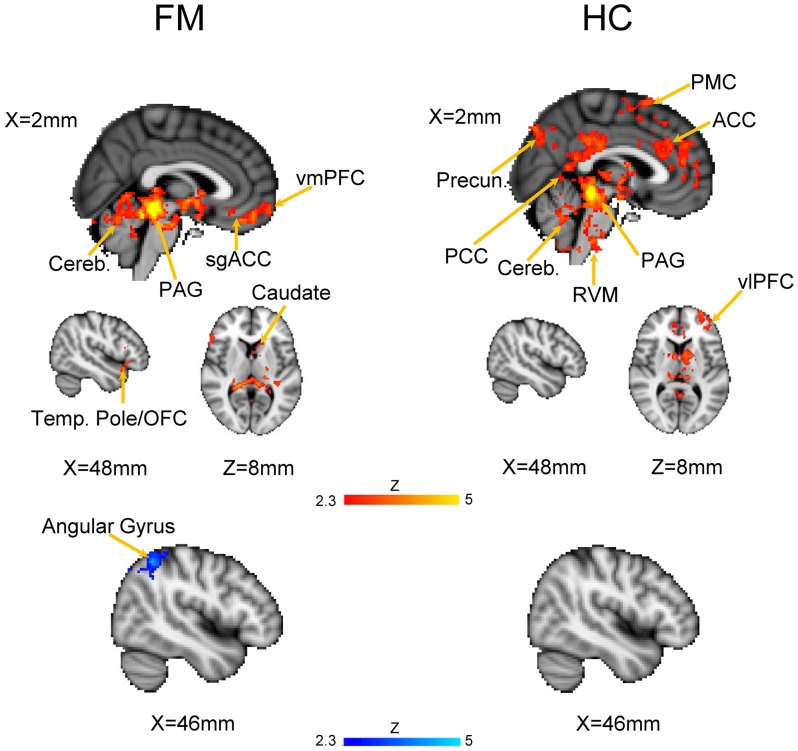
Functional connectivity (FC) of a PAG seed in patients with Fibromyalgia (FM; n = 23) and in healthy controls (HC; n = 16). Images are thresholded at a whole-brain family wise error rate-corrected Z > 2.3; cluster-based p < 0.05. Warm colors represent positive correlation, cold colors represent negative correlation. Cereb., cerebellum; vmPFC, ventromedial prefrontal cortex; sgACC, subgenual anterior cinculate cortex; PAG, periaqueducatal gray; OFC, orbitofrontal cortex; Temp. Pole, temporal pole; Precun., precuneus; PCC, posterior cingulate cortex; ACC, anterior cingulate cortex; PMC, premotor cortex; RVM, rostroventral medulla; vlPFC, ventrolateral PFC.